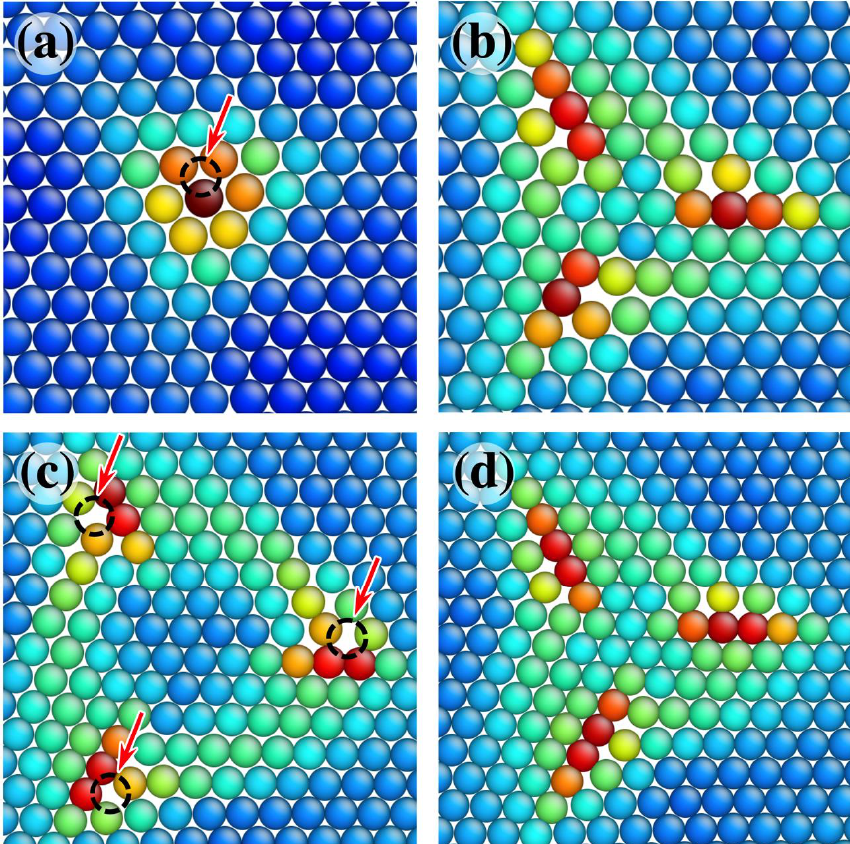
Figure 7. The structures of self-interstitials at the volume smeared node ( a , b ) and the volume condensed node with triangular structure ( c , d ). In ( a , b ) the structure of the volume smeared node with spiral pattern before and after the insertion of the interstitial in the dashed black circle. In ( c , d ) the structure of the volume condensed node with triangular dislocation pattern before and after the insertion of a interstitial at one of the jogs (dashed black